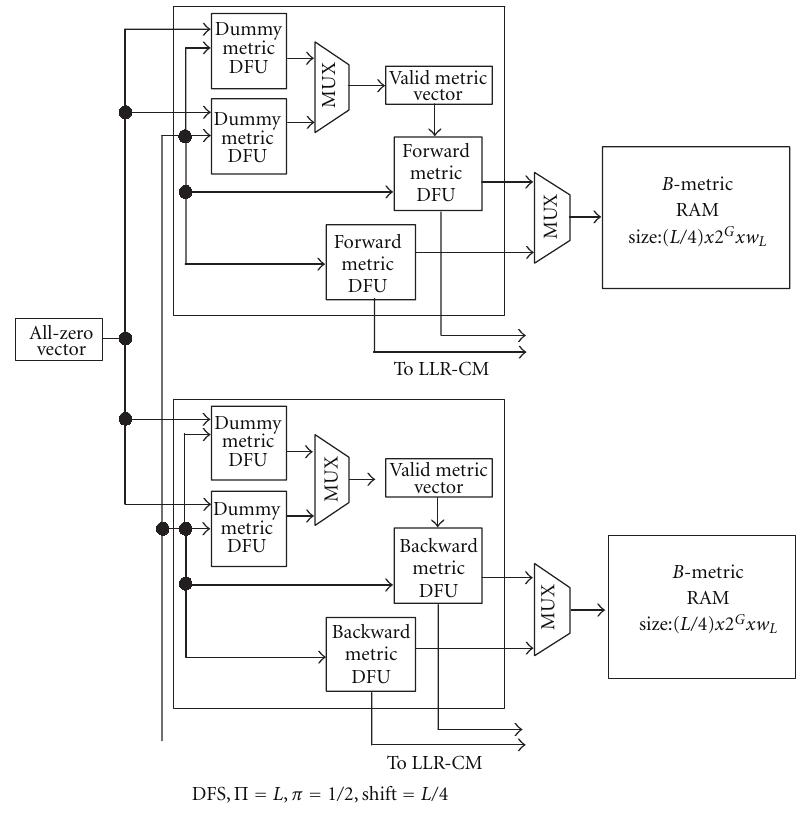
Figure 10: State metric calculation modules for double-flow structures.